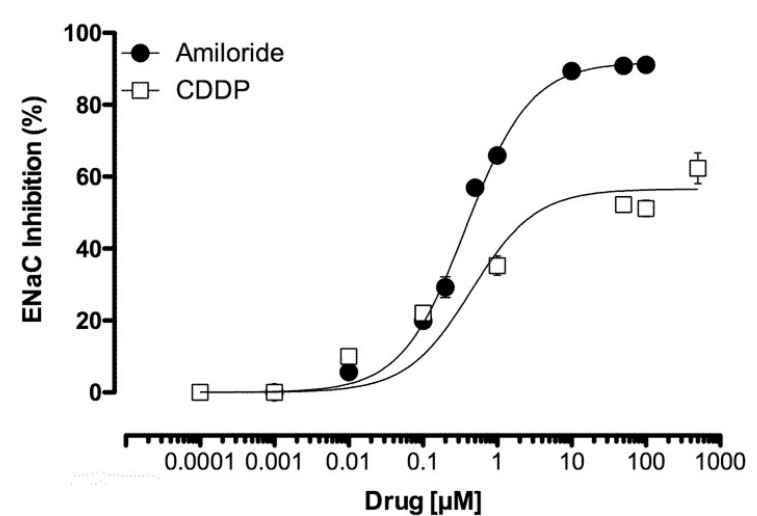
Figure 2. CDDP decreased the activity of the epithelial Na + channel (ENaC) in native murine Principal cells. ( A ) Representative current traces of ENaC in cell-attached patches made on the apical plasma membrane of Principal cells in freshly isolated tubules from naïve mice before (top) and after (bottom) treatment with 1.5 µ M CDDP. Negative pipette potential − 60 mV and inward Na + current downwards. ( B ) Summary graph of ( n = 7) paired experiments showing ENaC activity (NP o ) before and after treatment with CDDP. Summary data from experiments were identical to that shown in (A) * p < 0.05 vs. Before.